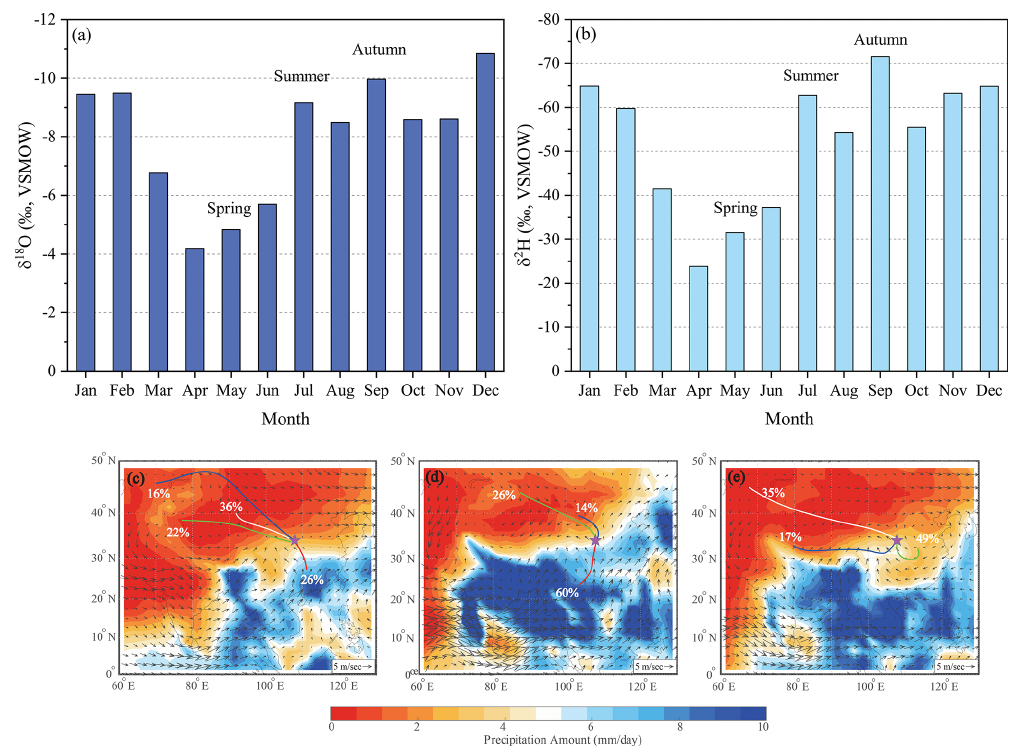
Figure 5. Variation of monthly mean precipitation δ 18 O (a) and δ 2 H (b) values at Xi’an station from the Global Network of Isotopes in Precipitation (GNIP) and cluster mean of moisture transport routes using the HYSPLIT model in May (c) , July (d) and September (e) , 2020. The background in (c) – (e) is the average precipitation (mmd − 1 ) and 850hPa wind vectors (arrows, ms − 1 ) in May (c) , July (d) , and September (e) in AD1979–2016 based on the database of the Global Precipitation Climatology Center (GPCC) (Becker et al., 2011) and the Modern-Era Retrospective analysis for Research and Applications (Rienecker et al.,